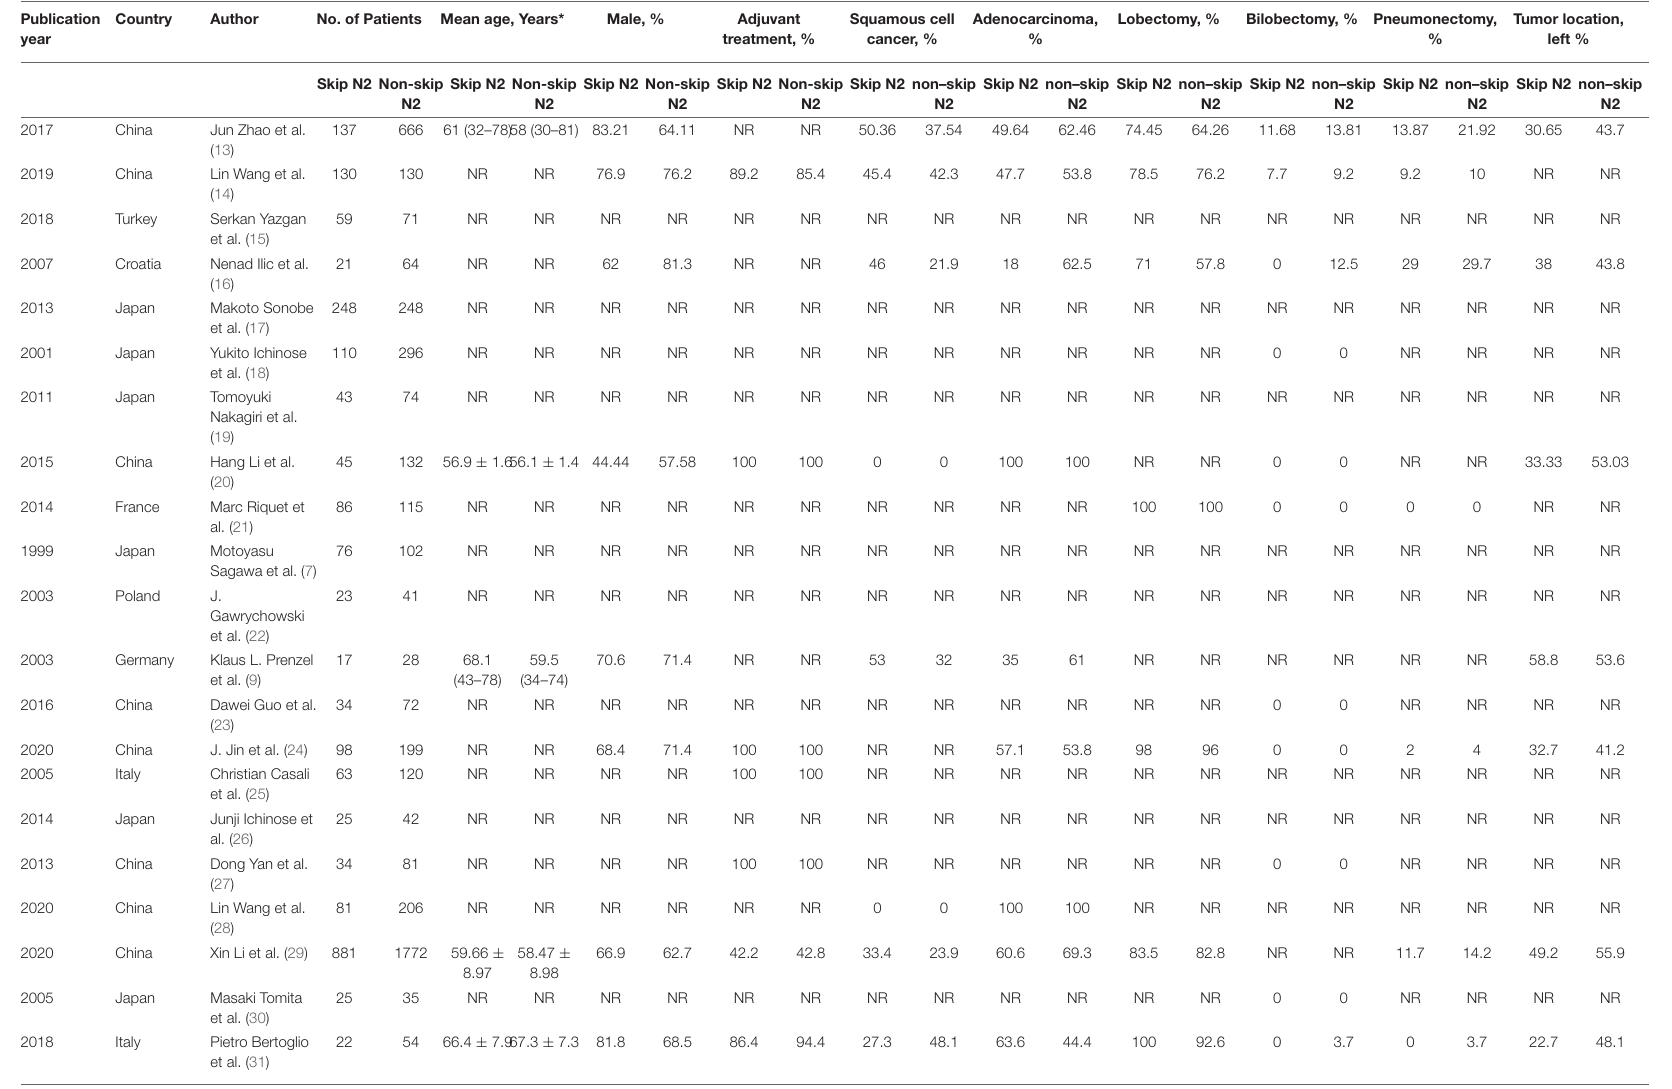
* Parenthesis indicates range; otherwise, data are expressed as mean ± SD. NR, not